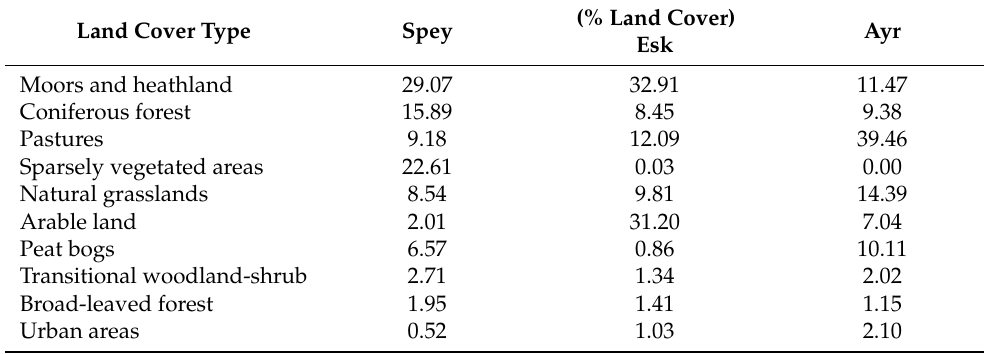
Table 1. Land cover types in the three study catchments as a percentage of overall area covered. Land Cover Type